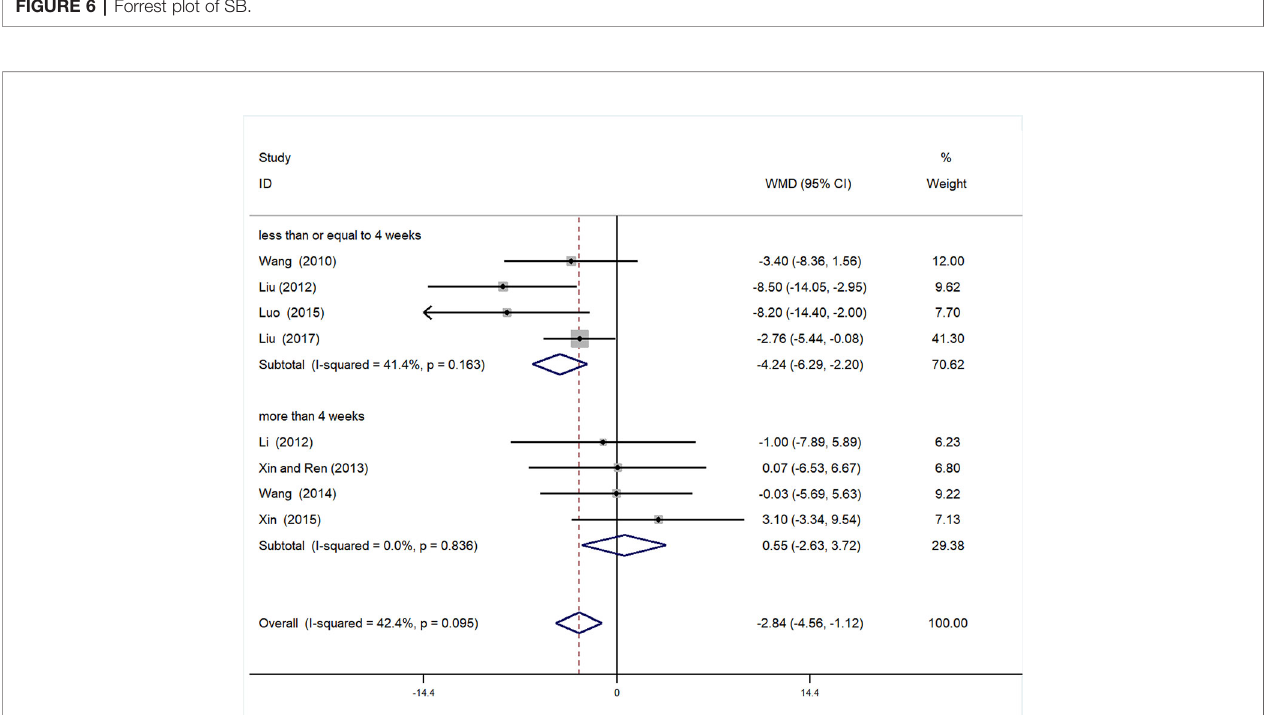
FIGURE 6 | Forrest plot of SB.